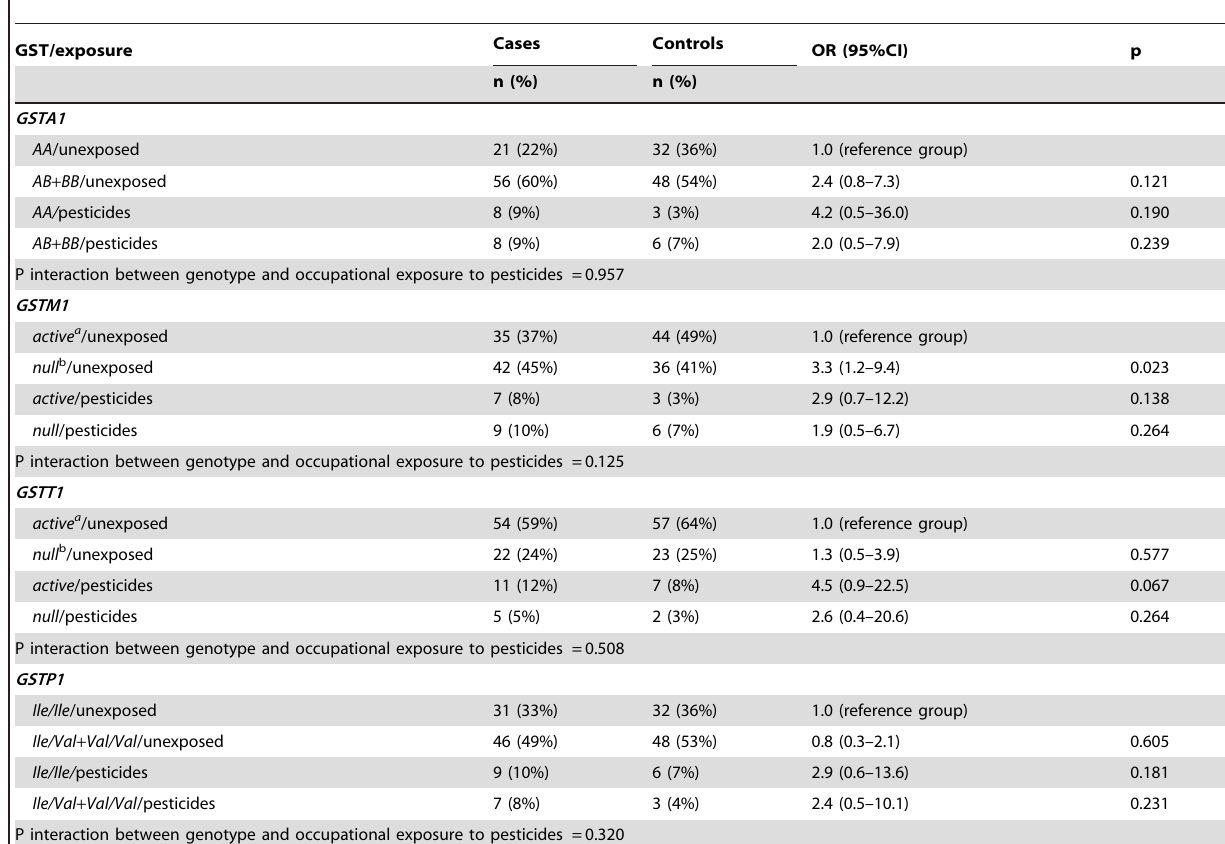
Table 5. Combined effect of occupational exposure to pesticides and GST genotype on bladder cancer risk in male